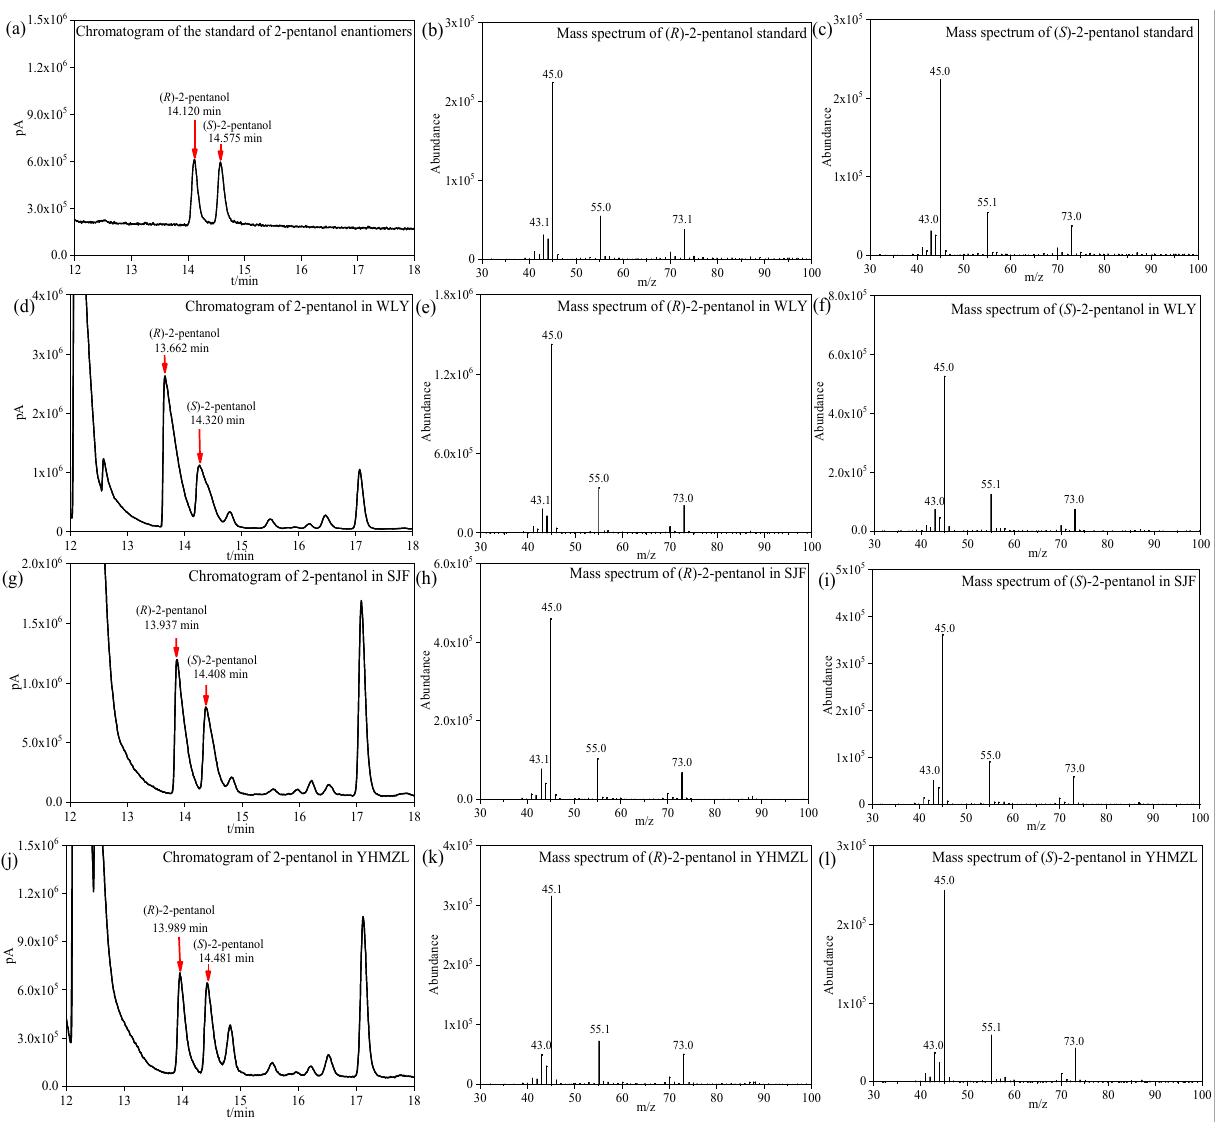
Figure 1. Enantiomeric separation chromatograms and exemplary mass spectra of 2-pentanol in representative Baijiu samples: ( a – c ): the standard of 2-pentanol enantiomers; ( d – f ): WLY sample; ( g – i ): SJF sample; ( j – l ): YHMZL sample.